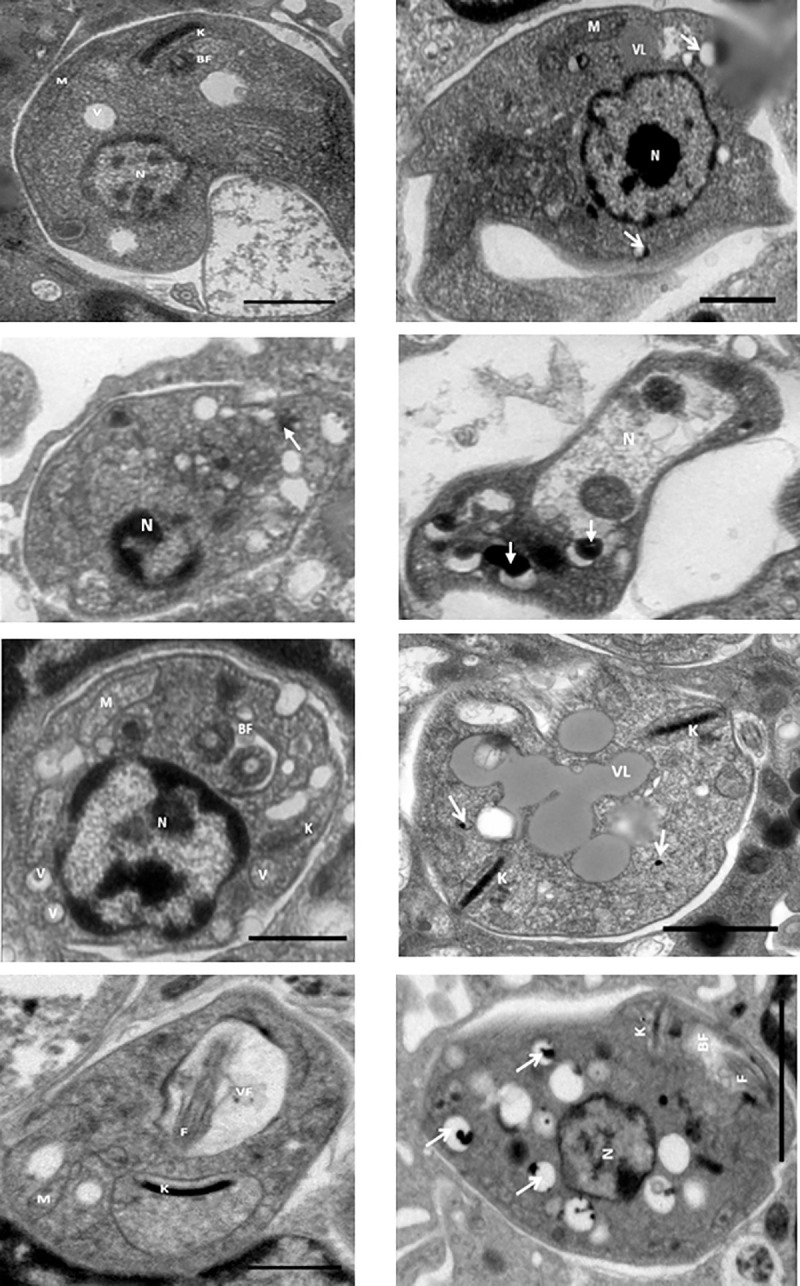
Ultrastructural alterations of Leishmania (Viannia) panamensis intracellular amastigotes.Untreated hMDMs (a and b). hMDMs treated with compounds (c and d) 1, (e and f) 2, and (g and h) 8. White arrows, acidocalcisomes. Visualization scale = 2 μm; 10,000X magnification. hMDMs, human monocyte-derived macrophages; N, nucleus; F, flagellae; K, kinetoplast; V, vacuole; LV, lipid vacuole (electrodense vacuoles); M, mitochondria; TEM, transmission electron microscopy.